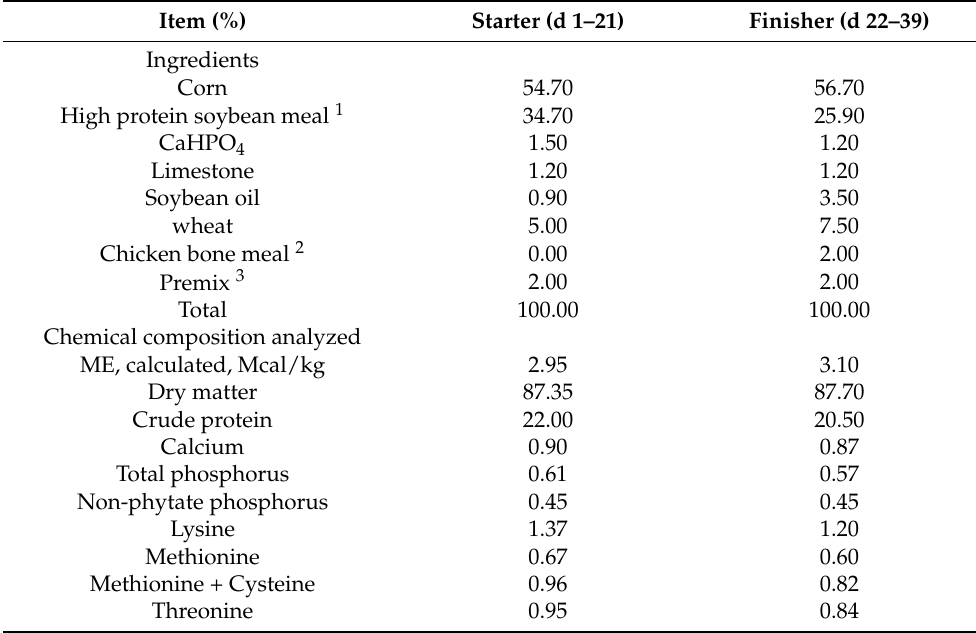
Table 1. Compositions and nutrient levels of basal diets for broilers